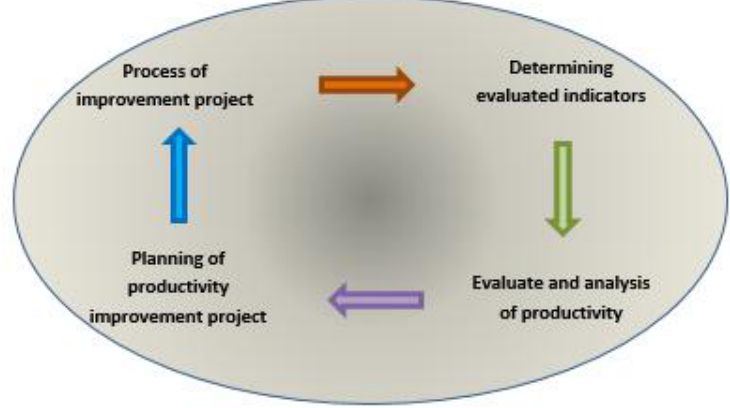
Fig. 1: Productivity management